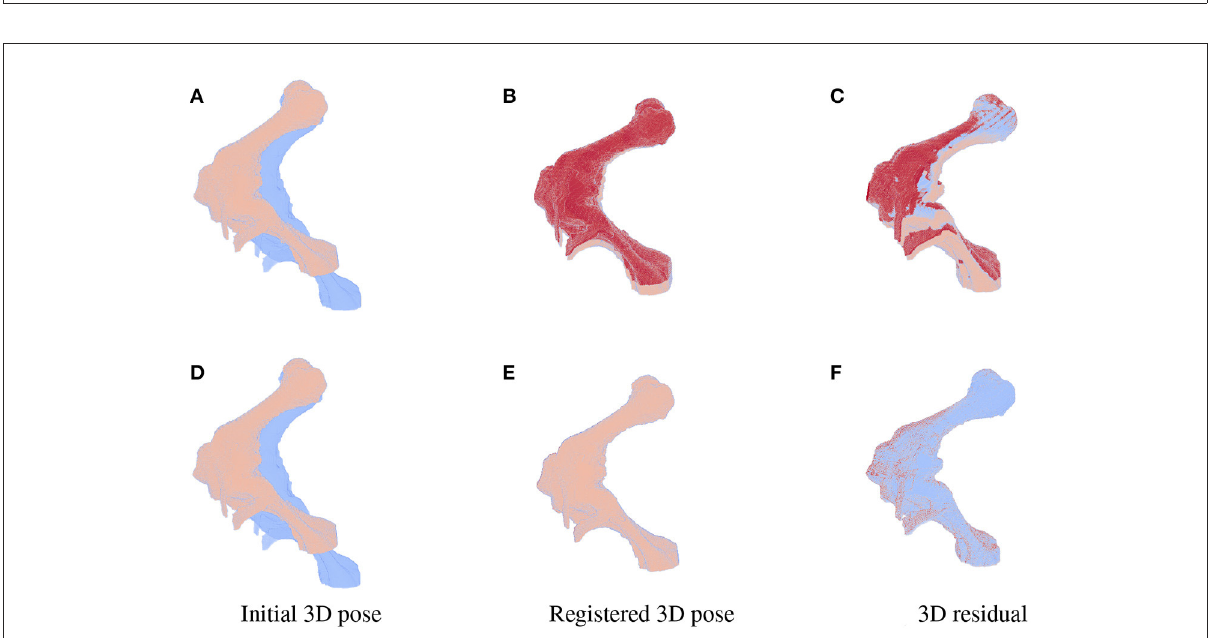
FIGURE14 3D views for the registration of the 3D pose of the limb (orange) with reference to the original volume (blue) for the high (first row) and low (second row) pose reconstruction errors. Initial reference (orange) and original (blue) poses are shown in (A,D) . With the high error, the 3D estimated volume (red) does not completely overlap the target volume (orange) (B) and the gaps are clearly visible as the red and orange volume residual in (C) . Accurate estimate of the parameters can be observed in (E,F) with overlapping on most of the ground-truth and registered volume [blue region in (F) ], only minor gaps are seen as the remaining darker spots scattered over the residual volume.